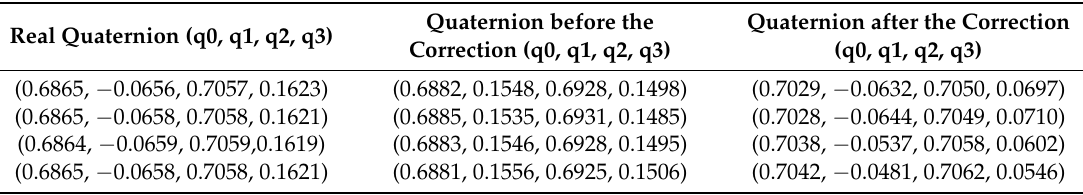
Table 6. Comparison of quaternion of the 0712